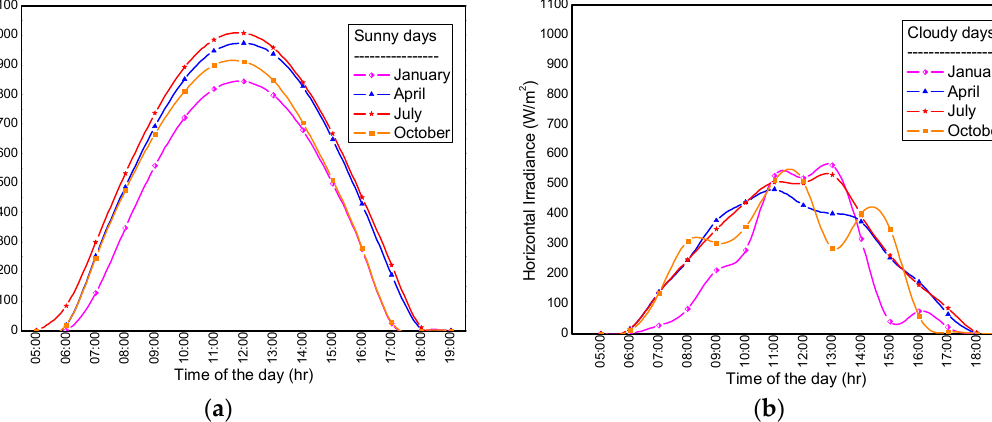
Figure 12. Global horizontal irradiance in different months of a year at case-study villages ( a ) on sunny days; ( b ) on cloudy days. Note that both locations (Bangkloy and Pongluek) are close to each other.